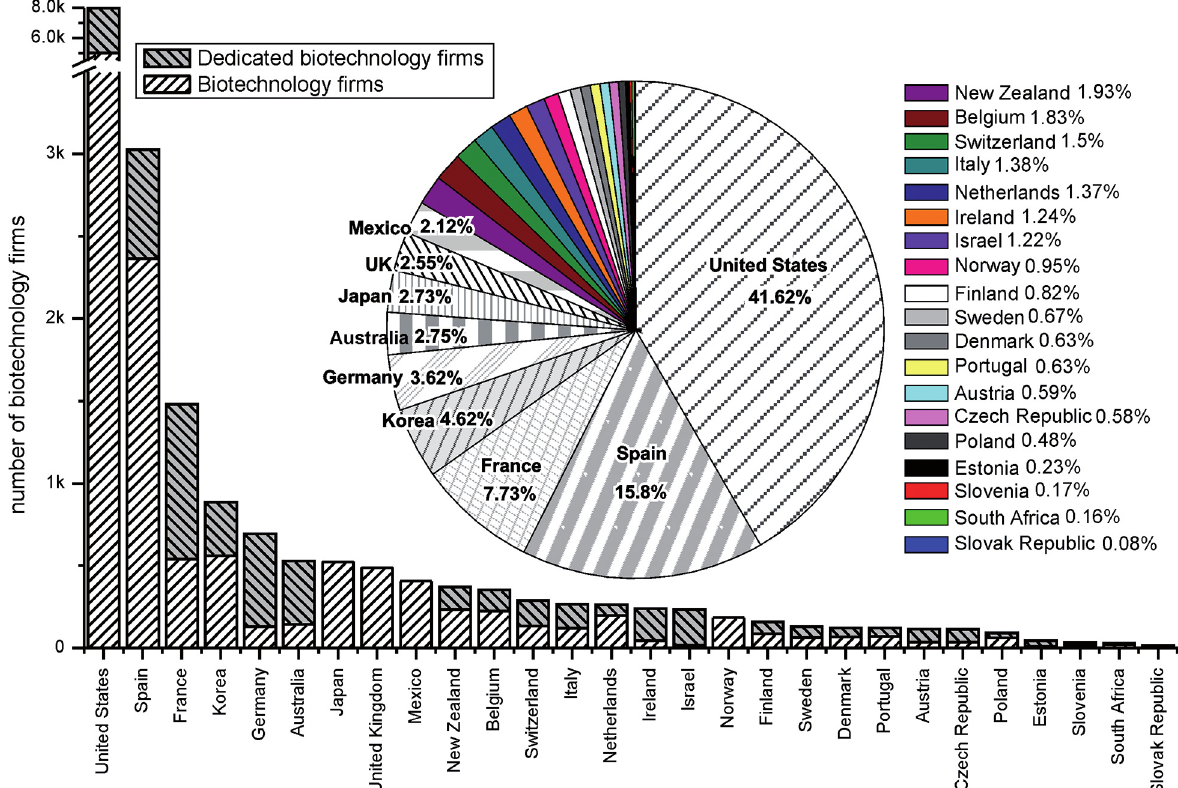
Fig. 1. Number of biotech companies in selected countries as per cent of the total, 2013 Source: own calculations based on OECD